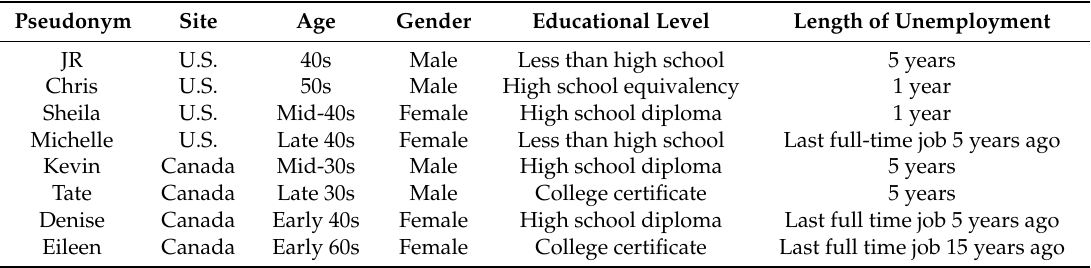
Table 1. Characteristics of Study